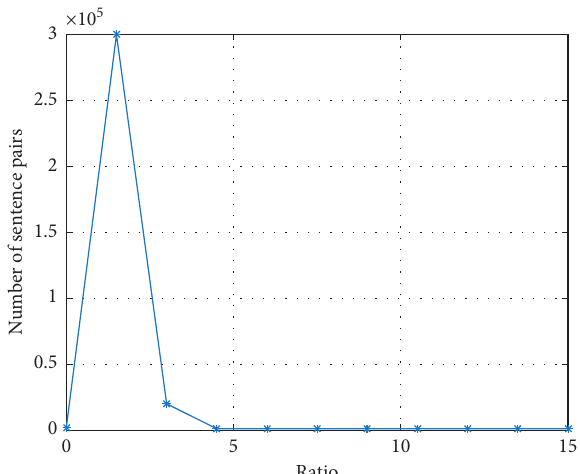
Figure 4: Statistics of length-to-length ratios of English-Chinese sentences.